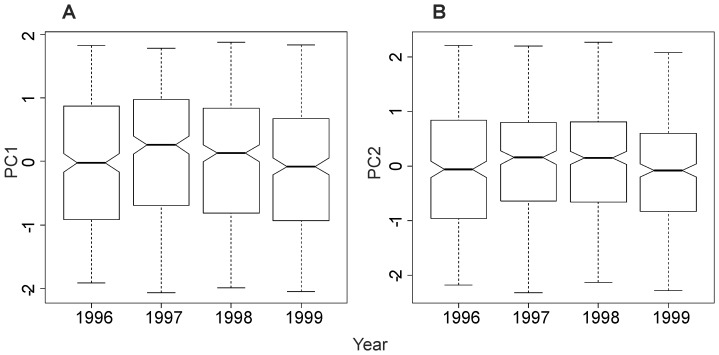
Variation of PCA scores according to years.(A) axis 1 (43%), (B) axis 2 (22%).